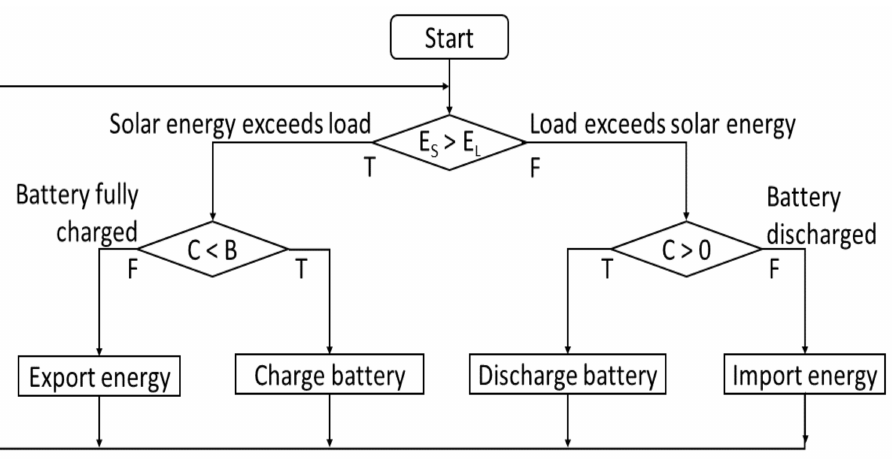
Figure 4. Simple battery control (solar charging